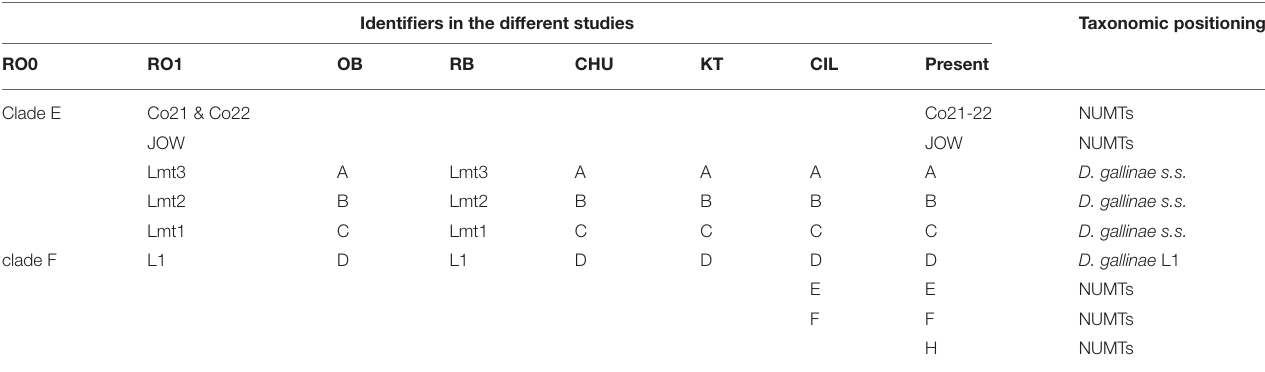
TABLE 4 | Correspondence of the different identifiers used in the studies included in this analysis to designate mitochondrial groups and their taxonomic positioning determined by comparing mitochondrial and nuclear